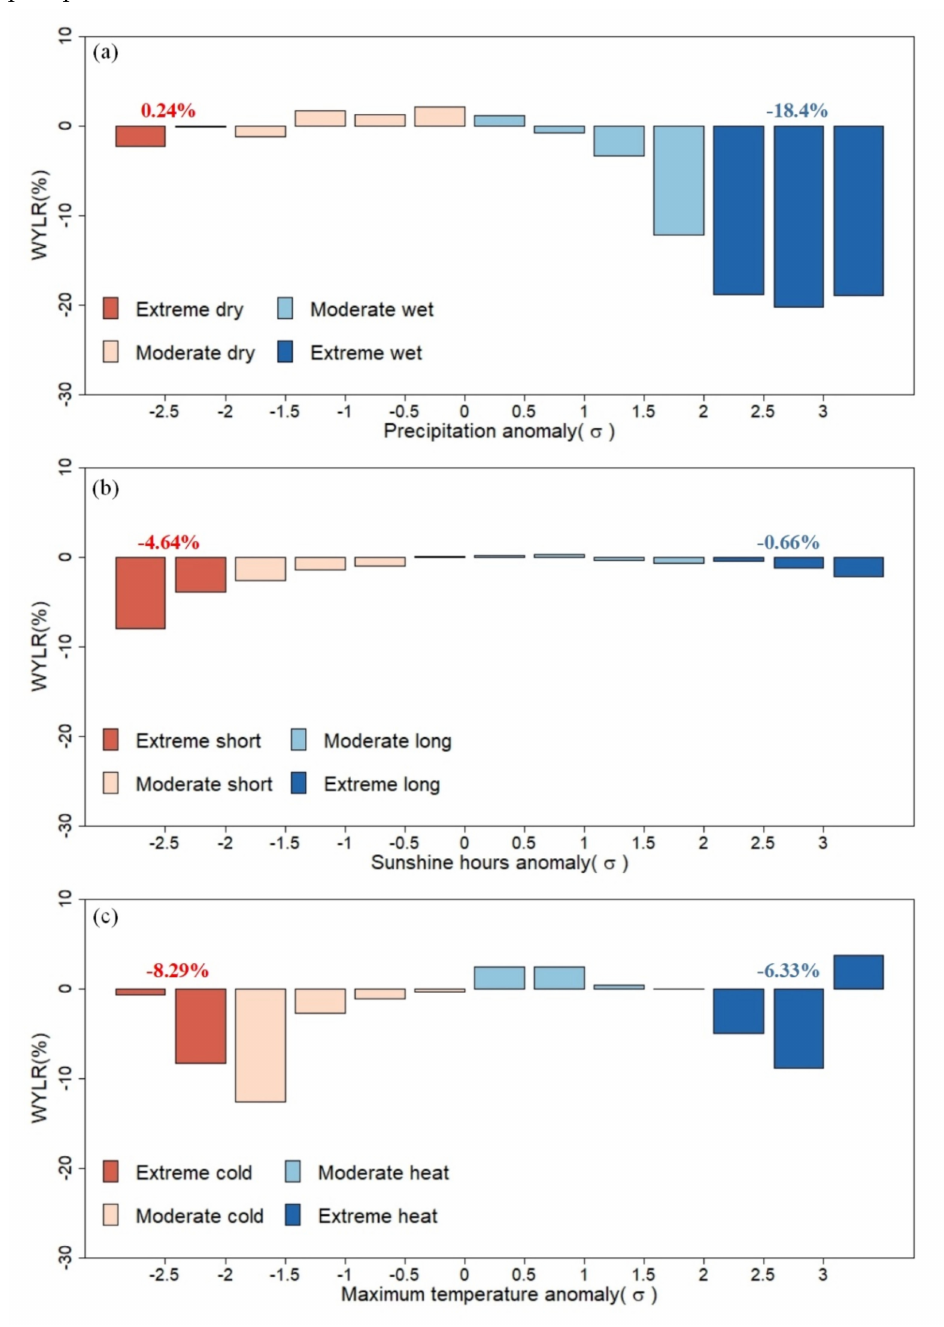
Figure 4. Impact of extreme climate factors, including precipitation ( a ), sunshine hours ( b ) and maximum temperature ( c ) on winter wheat yield middle and lower reaches of the Yangtze